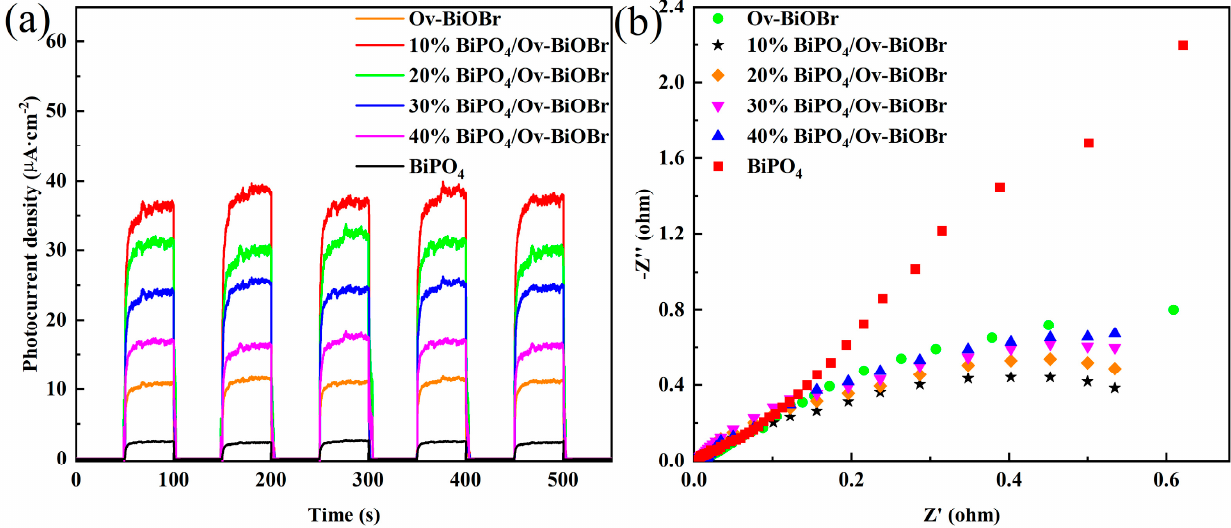
Figure 7. Photocurrent profiles ( a ) and impedance profiles ( b ) of the samples.